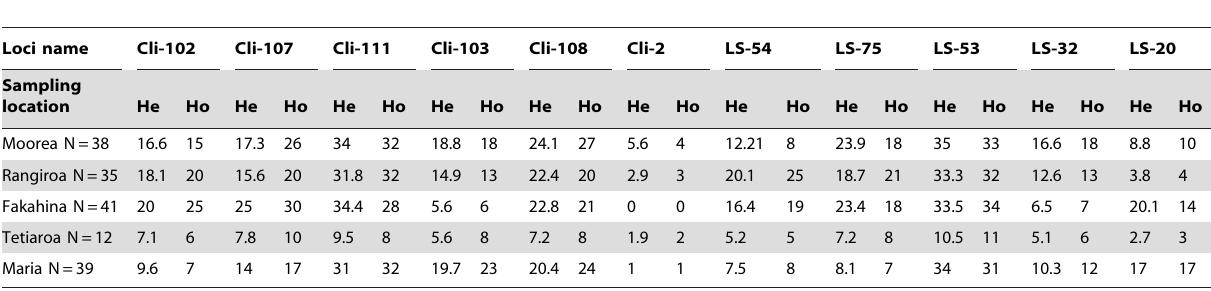
Table 1. Expected (He) and observed (Ho) heterozygosity for each locus and each deme.